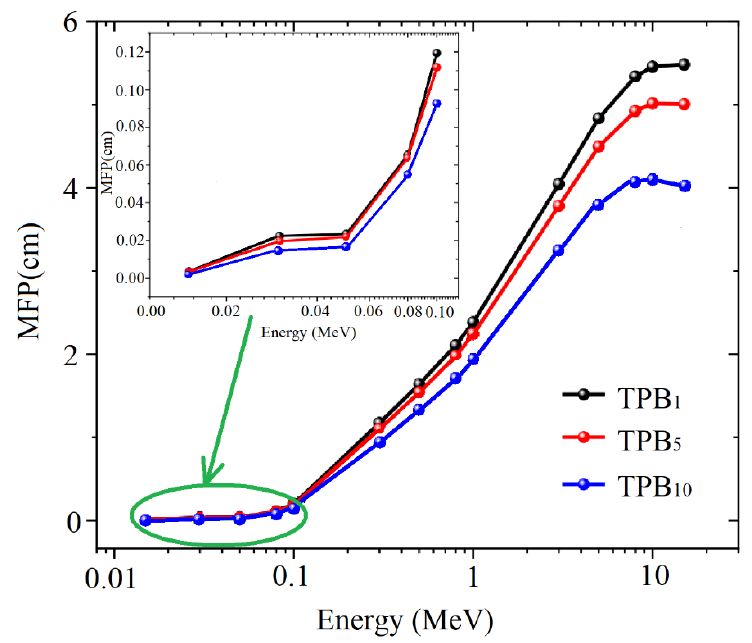
Figure 9. The mean free path (MFP) of glasses at different incident gamma ray energy.